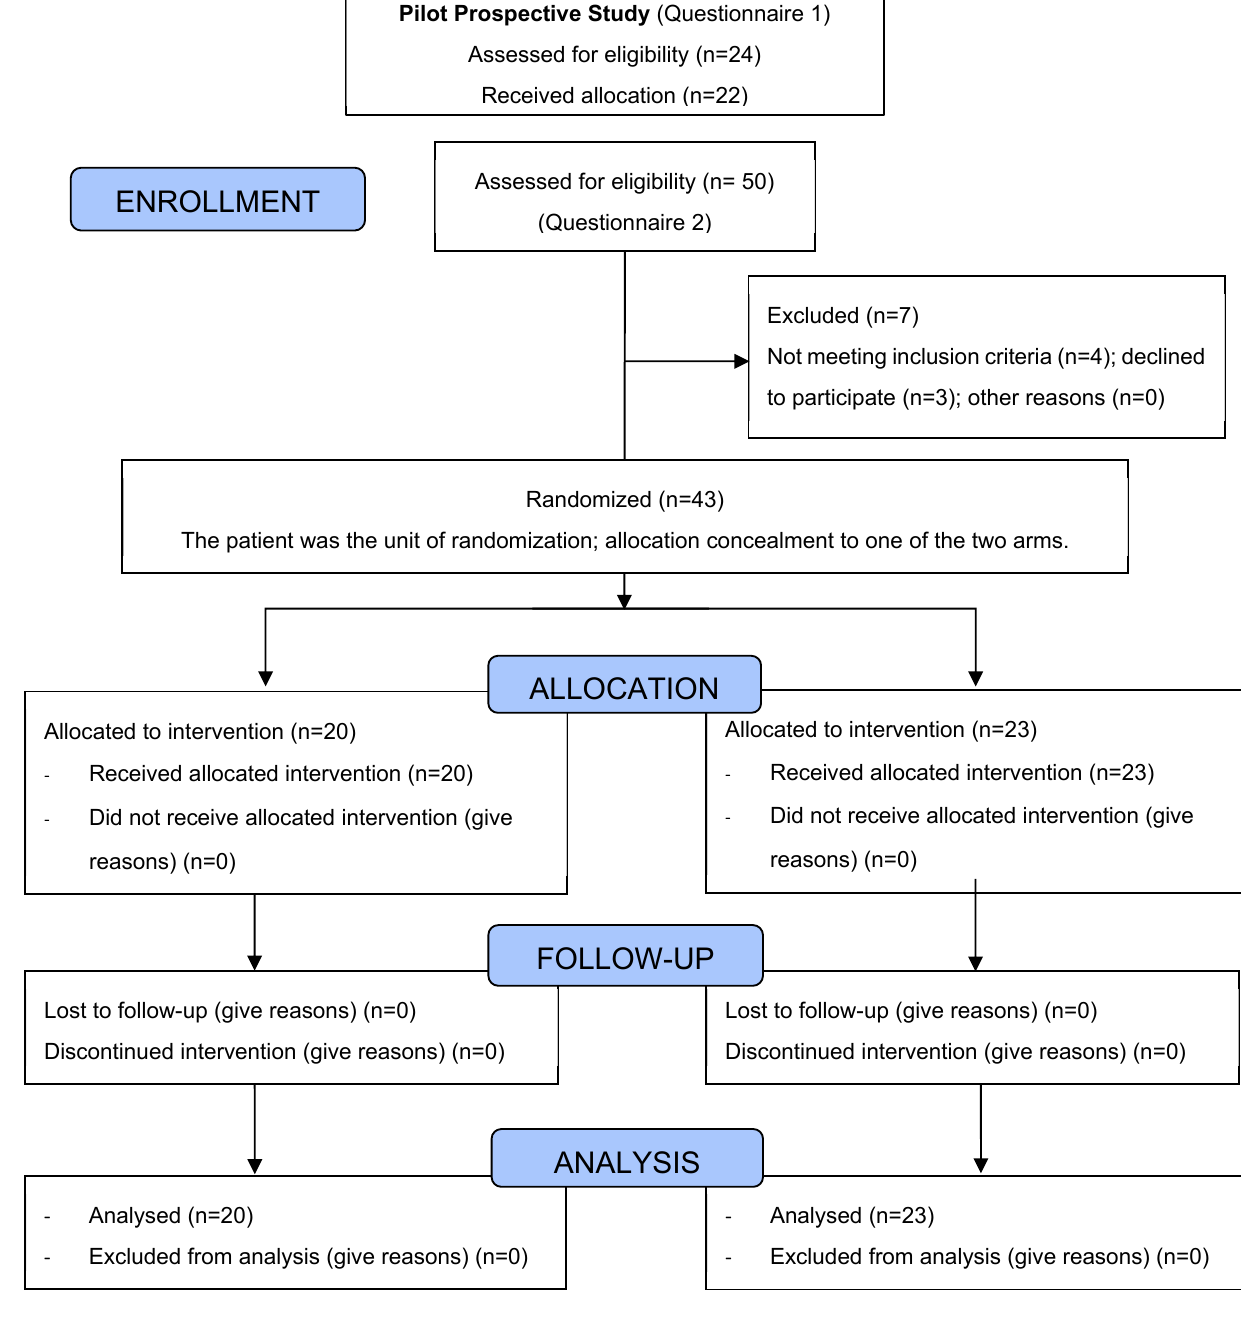
Figure 1. RCT Study CONSORT Diagram.